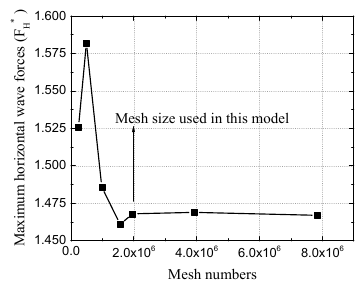
Figure 2. Variations of wave-induced maximum horizontal forces ( F H * = F Hmax /D ρ g H ) on piles for different mesh numbers.